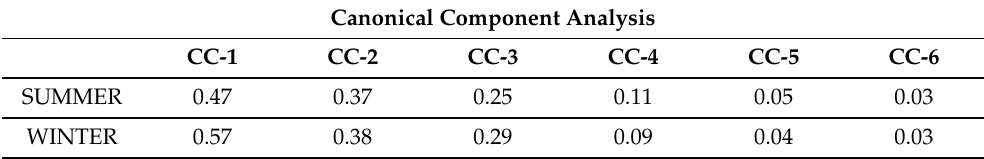
Table 5. Correlation coefficients for the 6 pairs of canonical components for the summer and winter seasons.